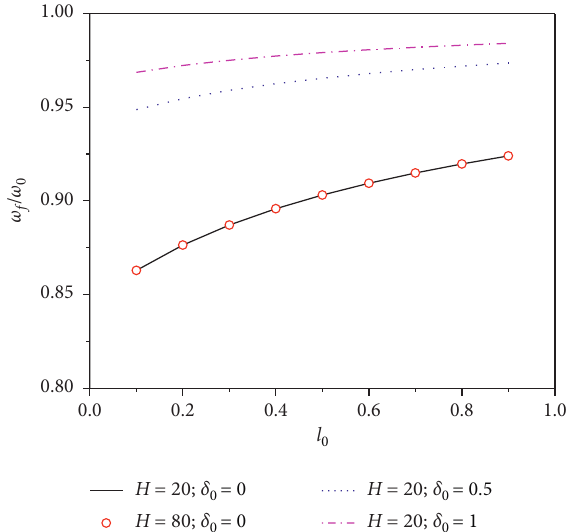
Figure 10: The variation in the ratio ω different values of σ